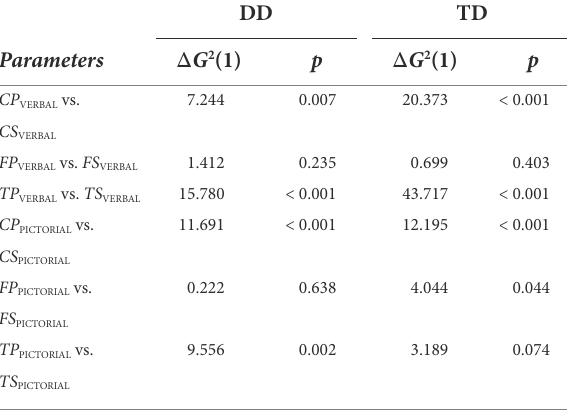
TABLE 6 Results of within-group comparisons between the model